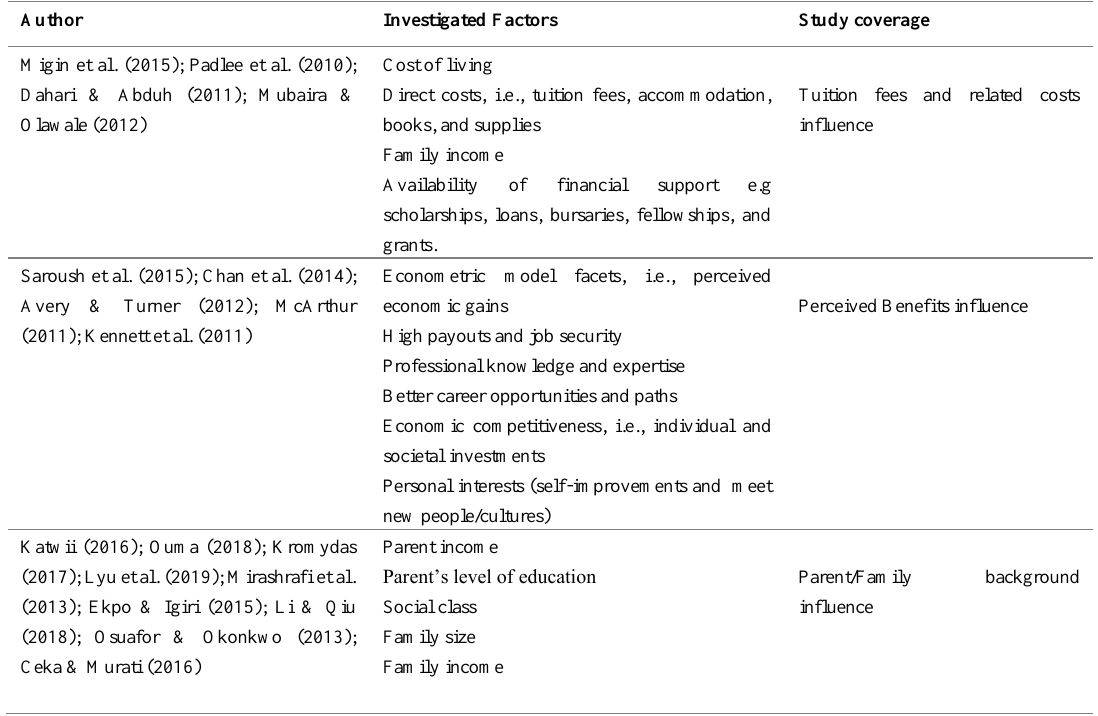
Table 2 : Summary of the literature